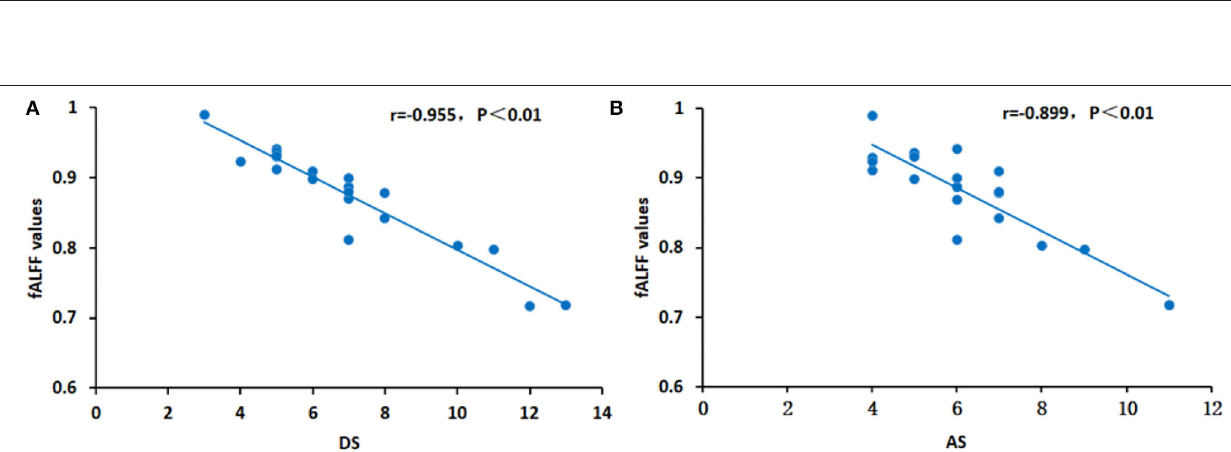
FIGURE 3 | ROC curve analysis of the average fALFF values in different cerebrum areas. AUCs: Cingulum_Ant_L: 0.983, Temporal_Sup_R: 1.000. Cingulum_Ant_L, left anterior cingulate gyrus; Temporal_Sup_R, right superior temporal gyrus; AUC, area under the curve; ROC, receiver operating characteristic.